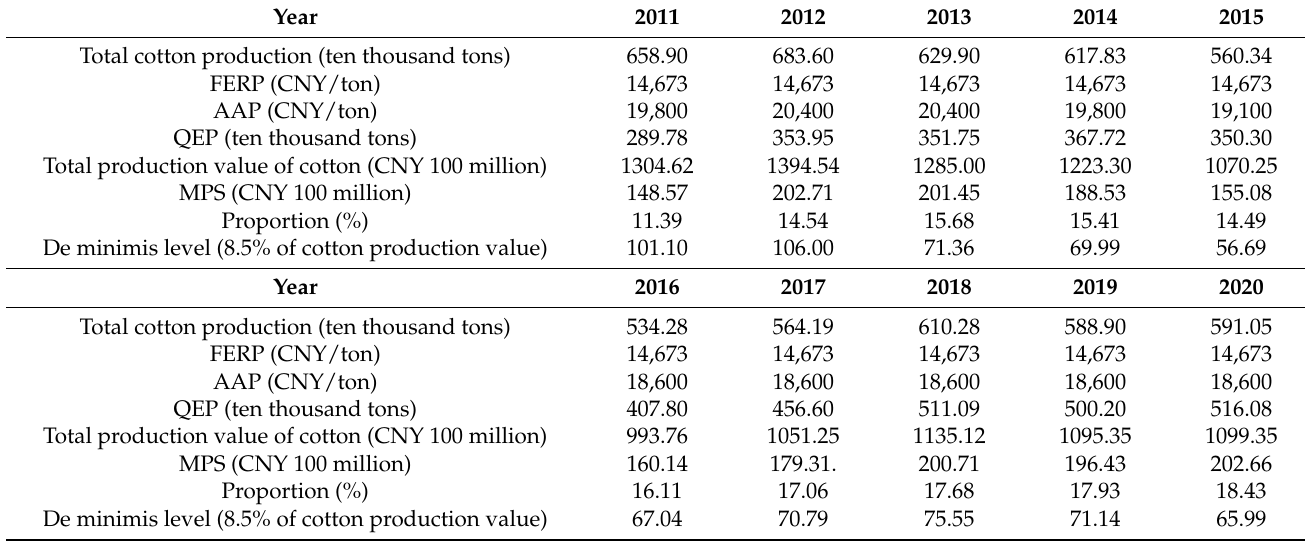
Table 1. Calculation data of China’s cotton subsidy policy support level from 2011 to